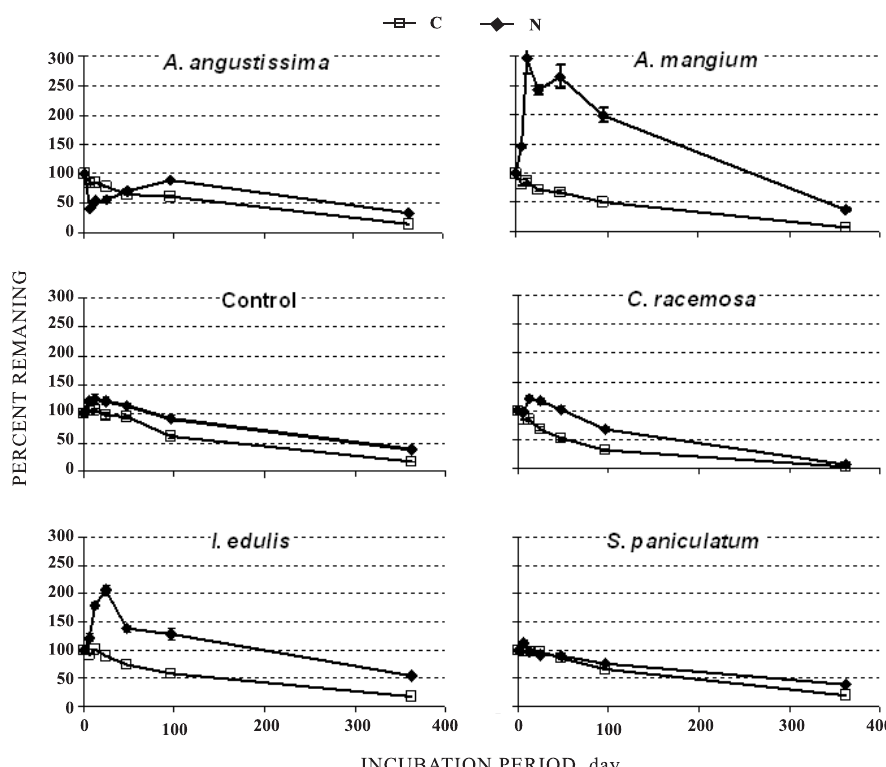
Figure 2. Remaining N and C in litter bags material during decomposition experiment for five leguminous species and a fallow vegetation (control). Bars represent stand